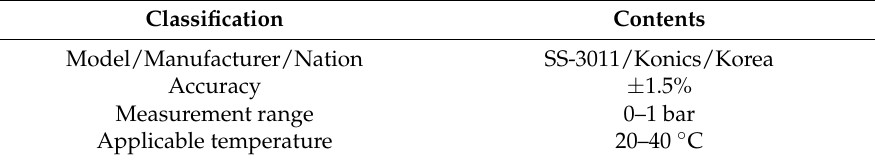
Table 3. Specifications of the pressure gauge.